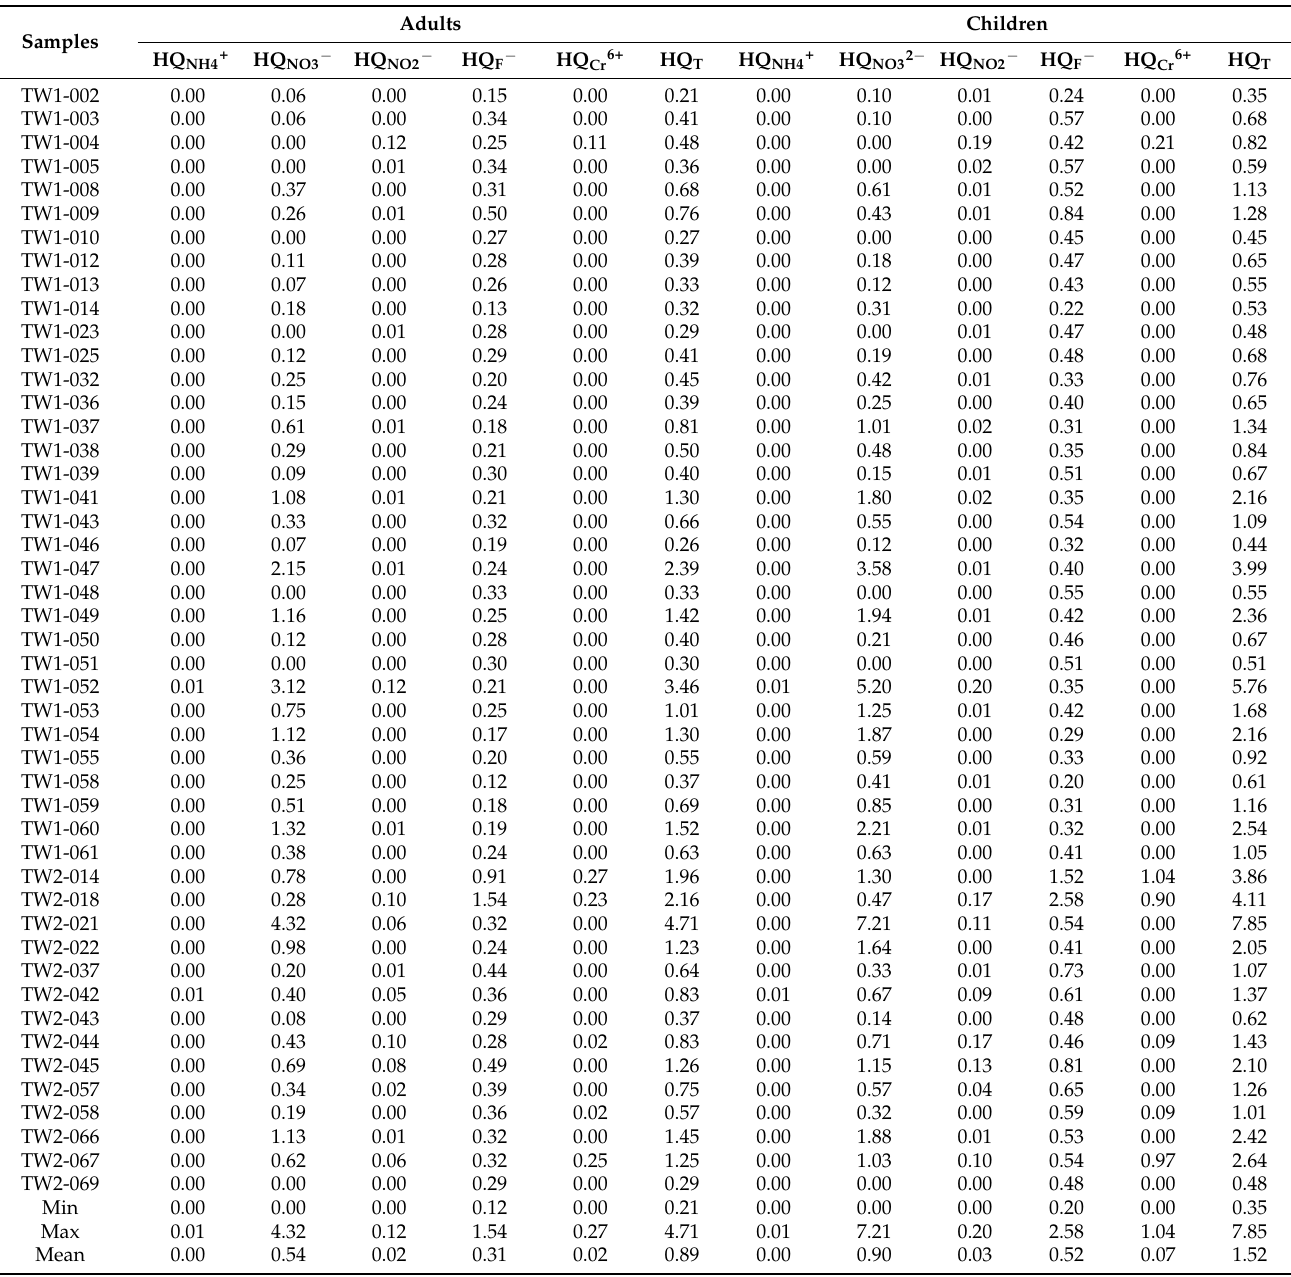
Table 6. Calculated hazard quotient (HQ) of non-carcinogenic risk for adults and children. Adults Samples